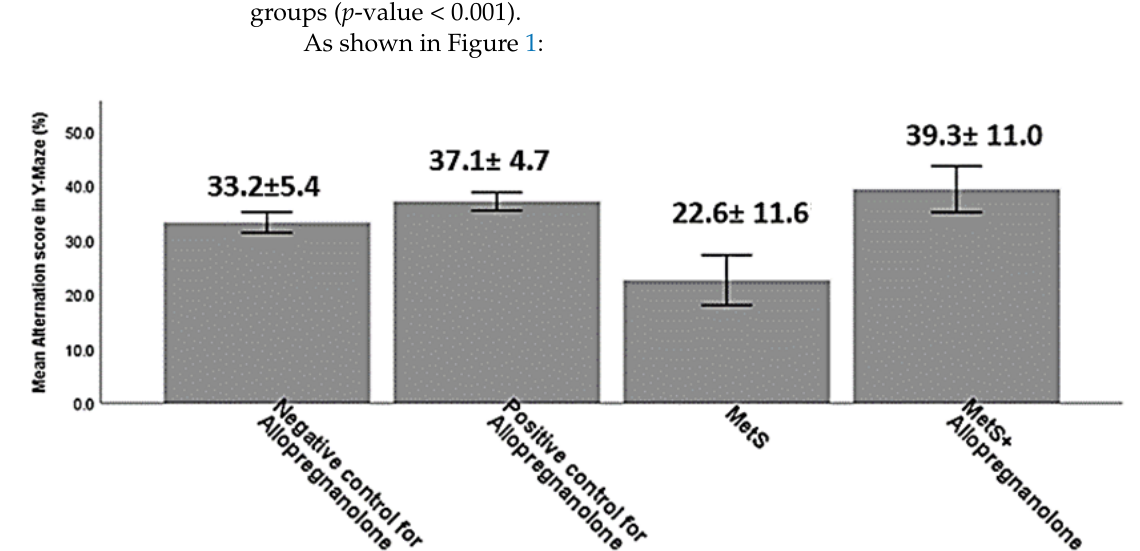
Figure 1. Alteration score in the studied groups in the Y-maze test. Alternation score (%) = (number of alternations)/(total arm entries − 2) × 100. Data are expressed as mean ± SD; n = 8 in each group. Alternation score in Y-Maze (%), negative control for Allopregnanolone (33.2 ± 5.4),